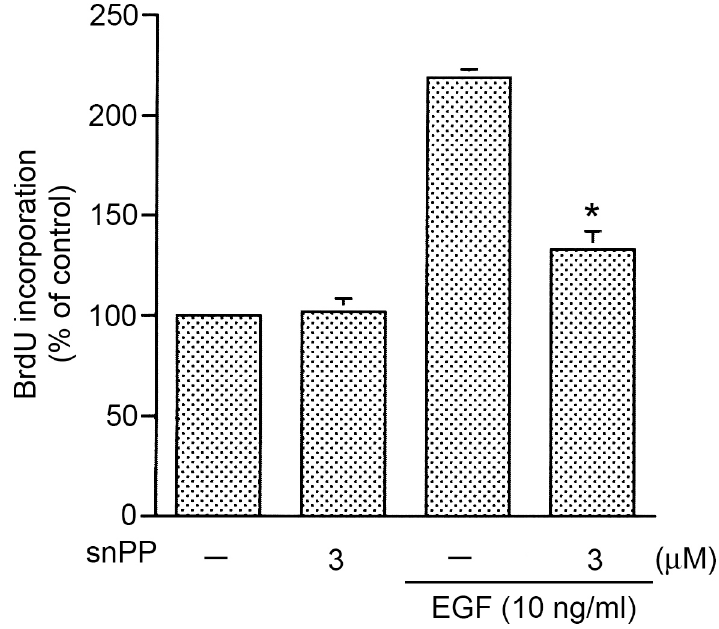
Figure 9. Involvement of heme oxygenase (HO)-1 in epidermal growth factor (EGF)-induced proliferation of HT-29 cells. Cells were pretreated for 30 min with 3 m M Sn(IV)protoporphyrin-1X (snPP) and then stimulated with 10 ng/ml EGF for another 48 h. A BrdU cell proliferation assay was carried out as described in ‘‘Materials and Methods’’. Data are presented as the mean 6 SEM of three experiments. * p , 0.05, compared to EGF treatment.